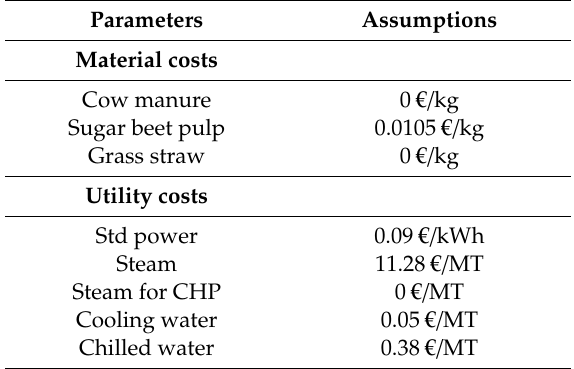
Table 9. Assumptions used to model the annual operating